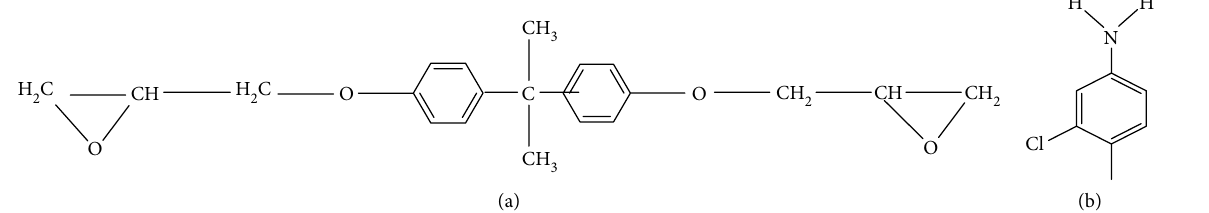
Figure 1: The chemical structure of: (a) bisphenol-A diglycidyl ether, and (b)